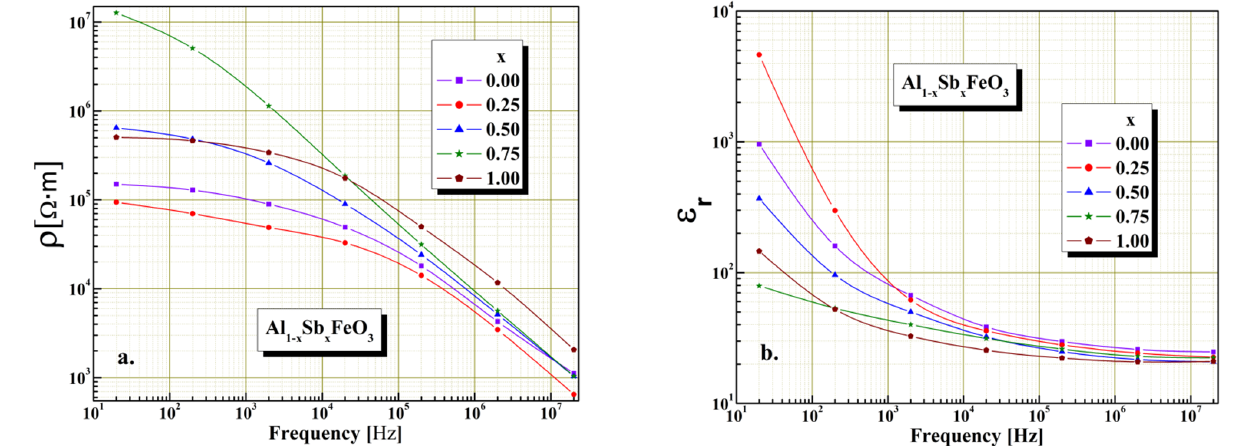
Figure 7. The frequency influence on electrical resistivity ( a ) and relative permittivity ( b ) without humidity for Al 1-x Sb x FeO 3 perovskites.